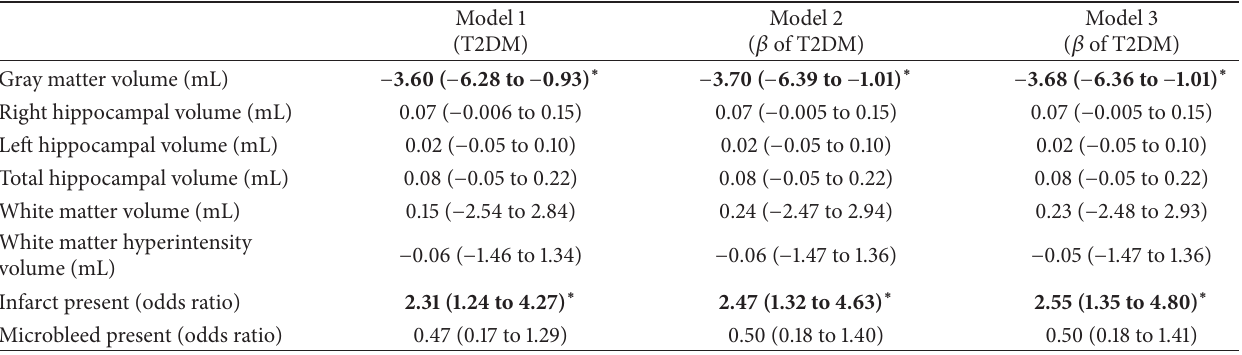
Table 3: Association between T2DM and MRI